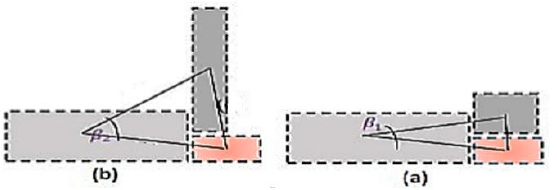
Figure 4. Enclosing some of boxes interspersed with unused space as a one block B